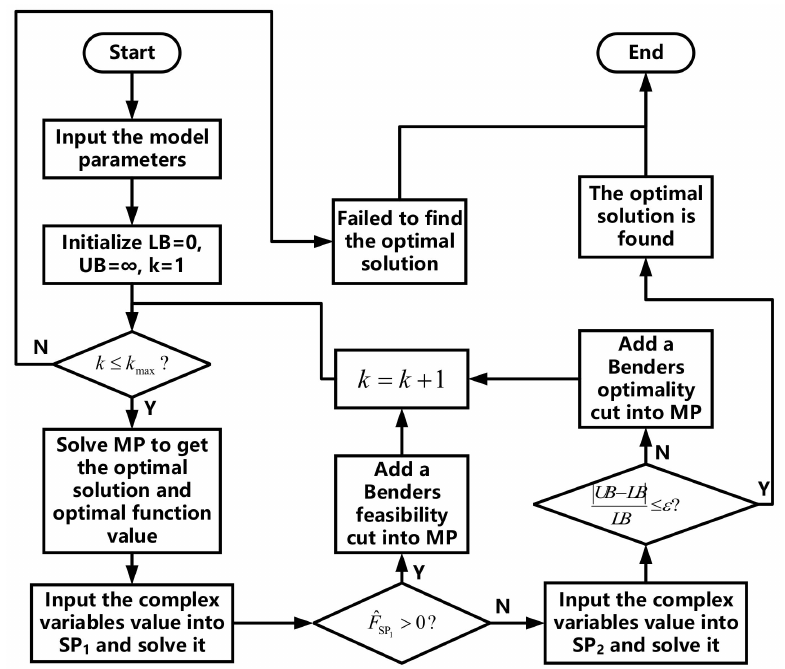
Figure 5. Flow chart of Benders decomposition for application to ( P 2